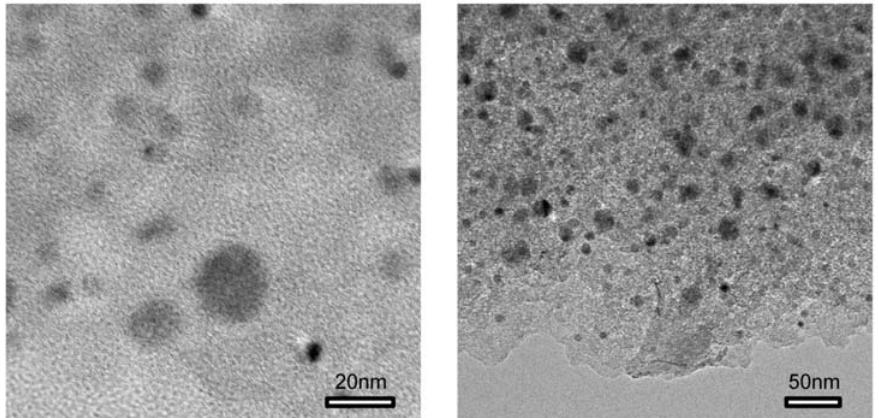
Figure 8. HRTEM micrographs of the fresh Ni/C catalyst.